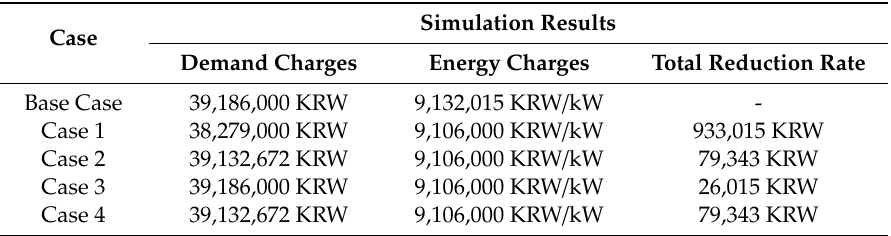
Table 4. Simulation